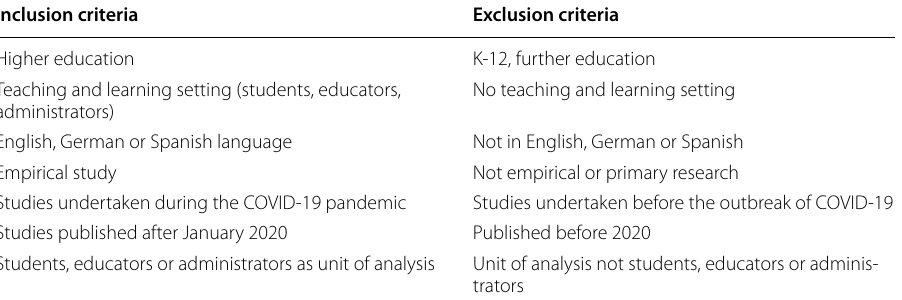
Table 3 Inclusion and exclusion criteria Inclusion